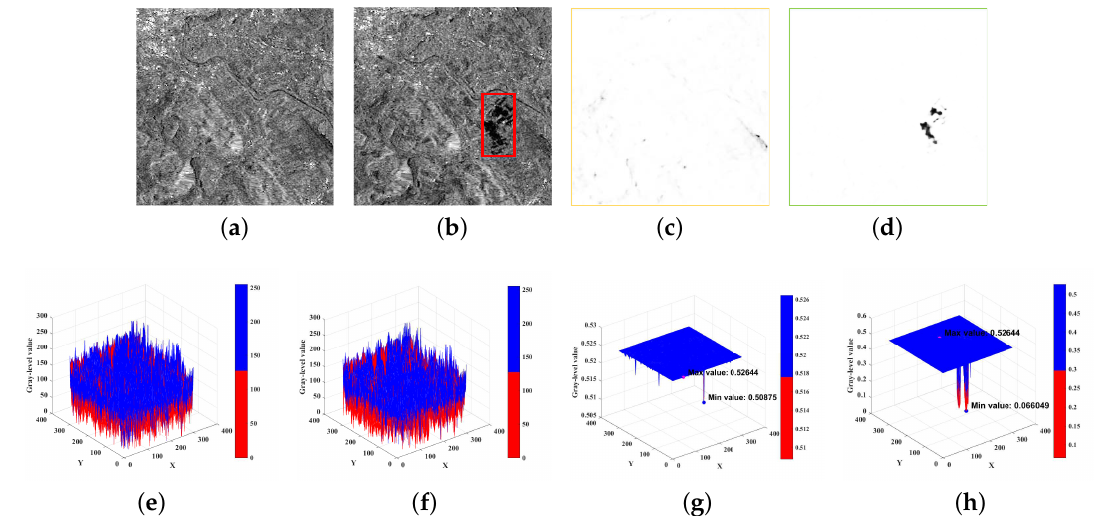
Figure A2. Comparison between original images and feature maps on Bern data set: ( a ) Original image I 1 , ( b ) Original image I 2 , ( c ) Feature map (estimated probability) F 1 , ( d ) Feature map (estimated probability) F 2 , ( e ) 3D display of image I 1 , ( f ) 3D display of image I 2 , ( g ) 3D display of feature map F 1 , ( h ) 3D display of feature map F 2